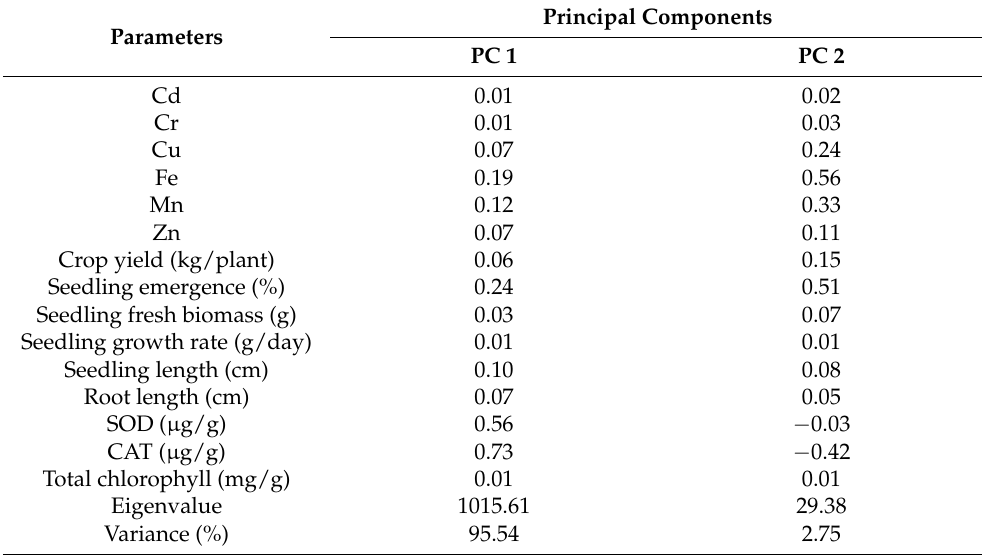
Table 6. Principal component analysis (PCA) results of interaction between metal element accumula- tion and of Ridge gourd ( L. acutangula ) response grown under different sewage sludge (SS) and plant growth-promoting rhizobia (PGPR)